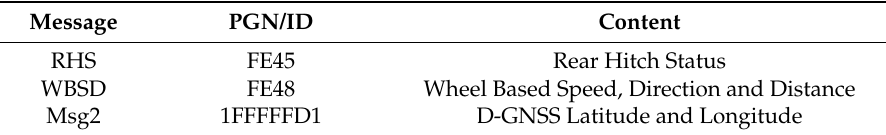
Figure 2. An example of an ISOBUS message as retrieved from the data logger. Table 1. Messages used for the area-related analysis.